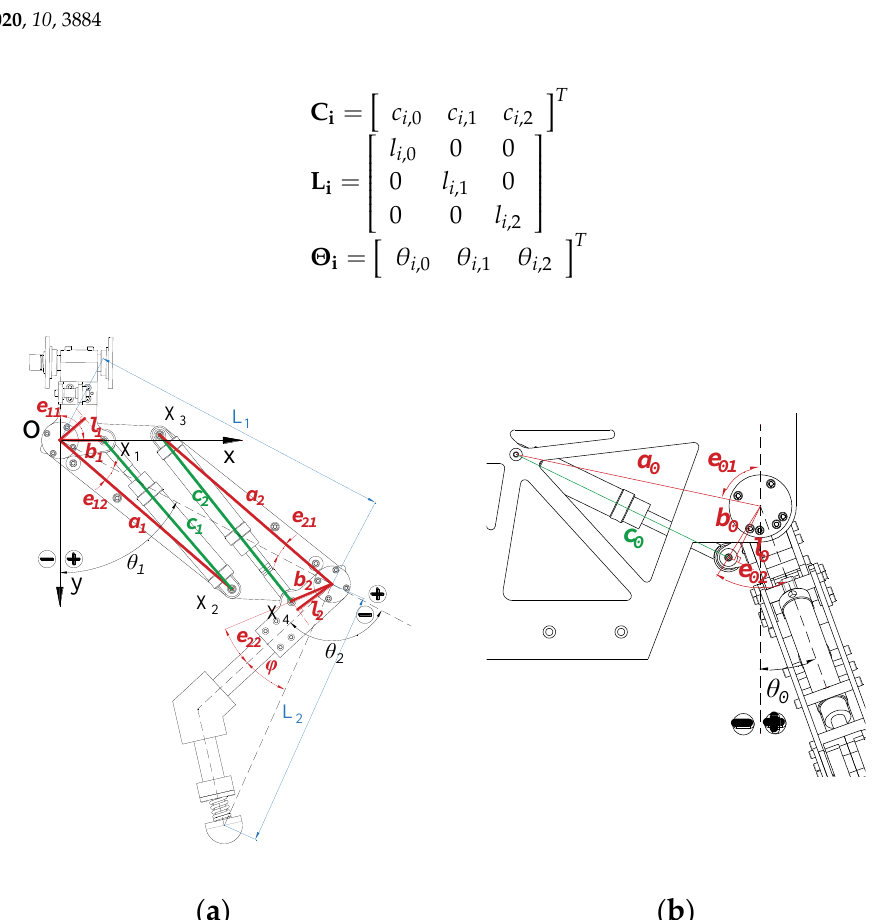
Figure 3. Geometric parameters of the leg structure: ( a ) hip and knee joint; ( b ) root joint.